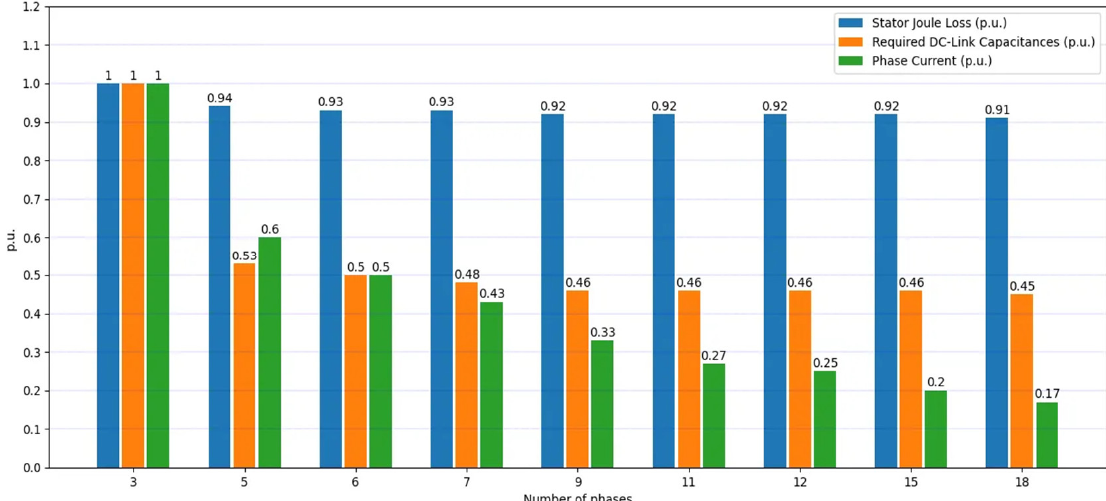
Figure 2. Joule loss, phase current, and required dc-link capacitance in p.u. for different numbers of phases, assuming constant power.